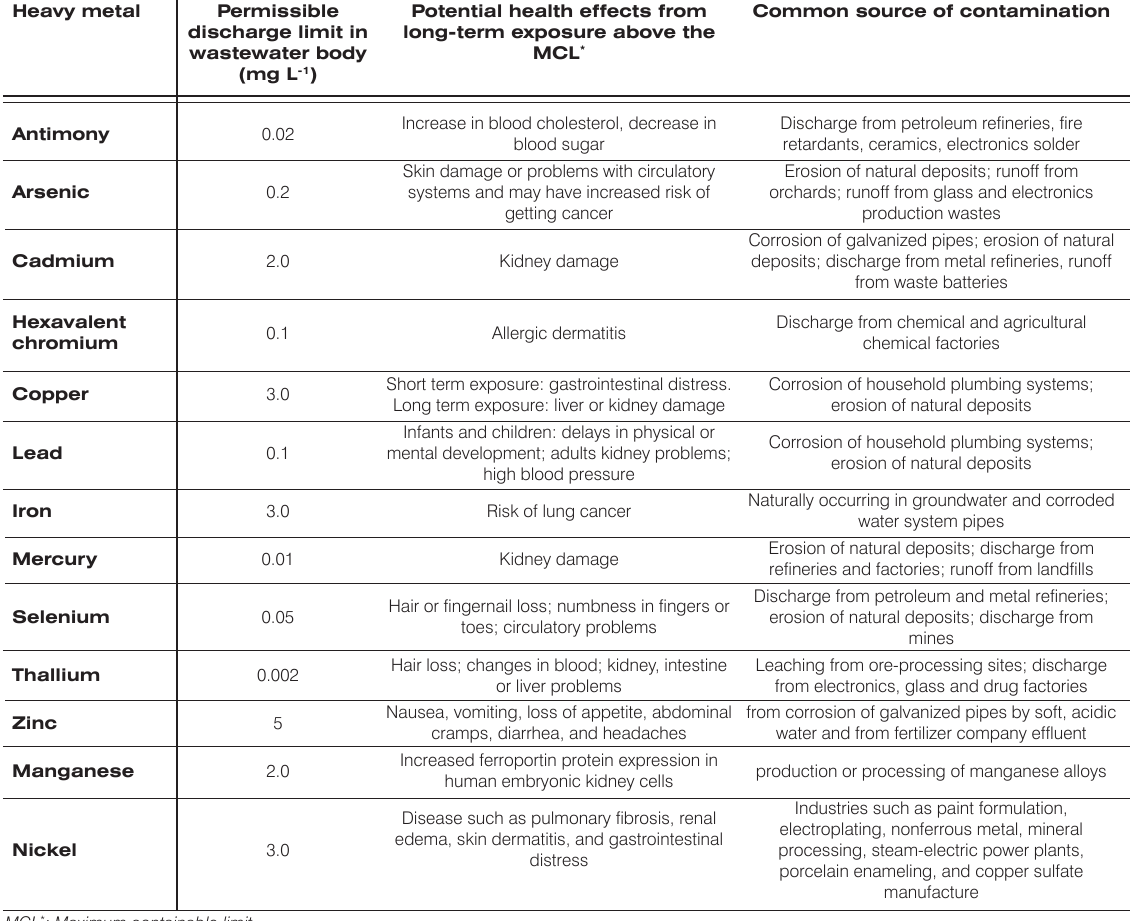
Table 1. Discharge limit of various heavy metals, their potential health effects and common sources as per